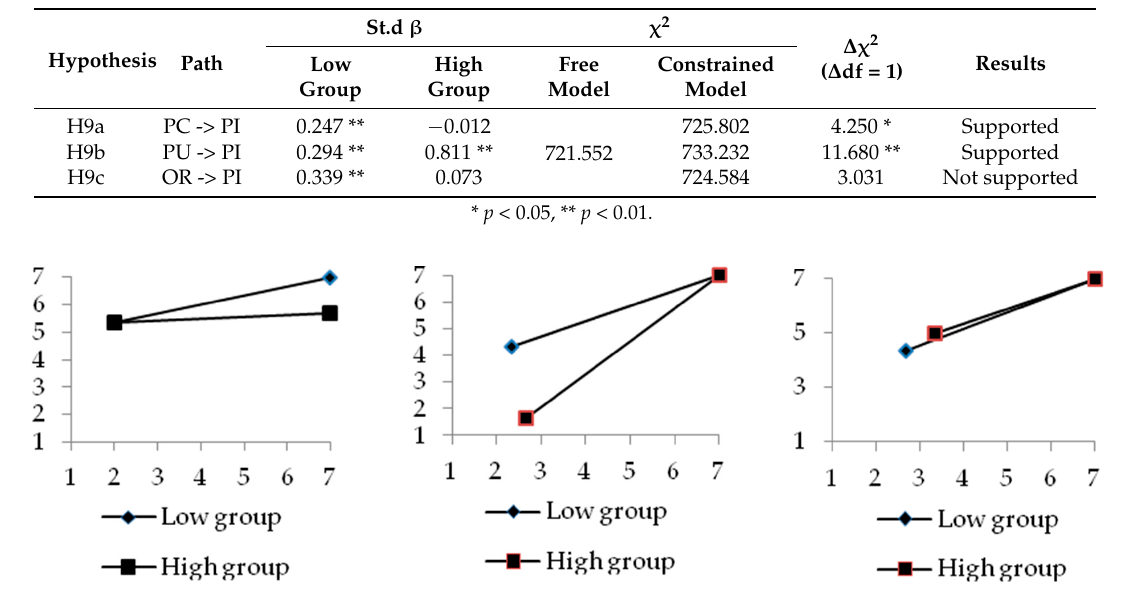
Table 8. Summary of crosstab analysis.